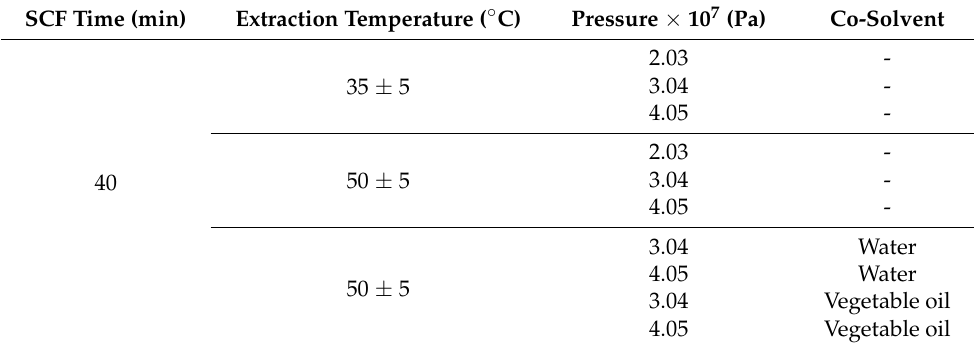
Table 2. Supercritical extraction conditions.